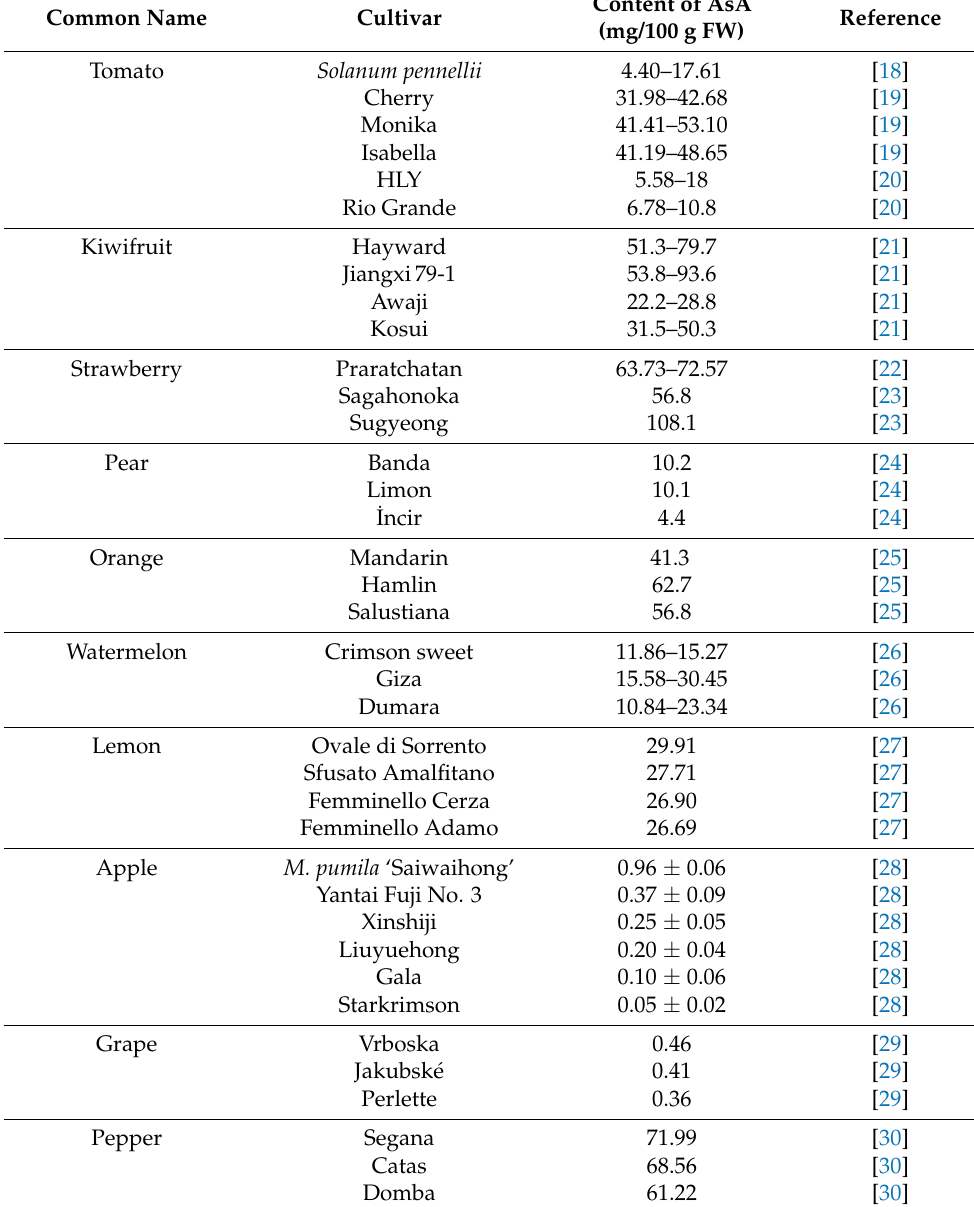
Table 1. AsA content in fruits of different